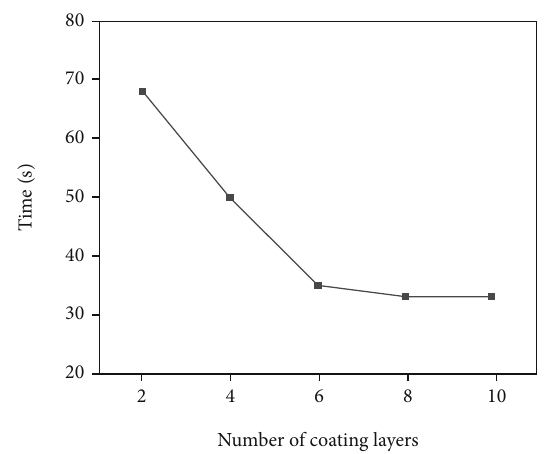
Figure 5: The change of deicing time with the number of coating layers.